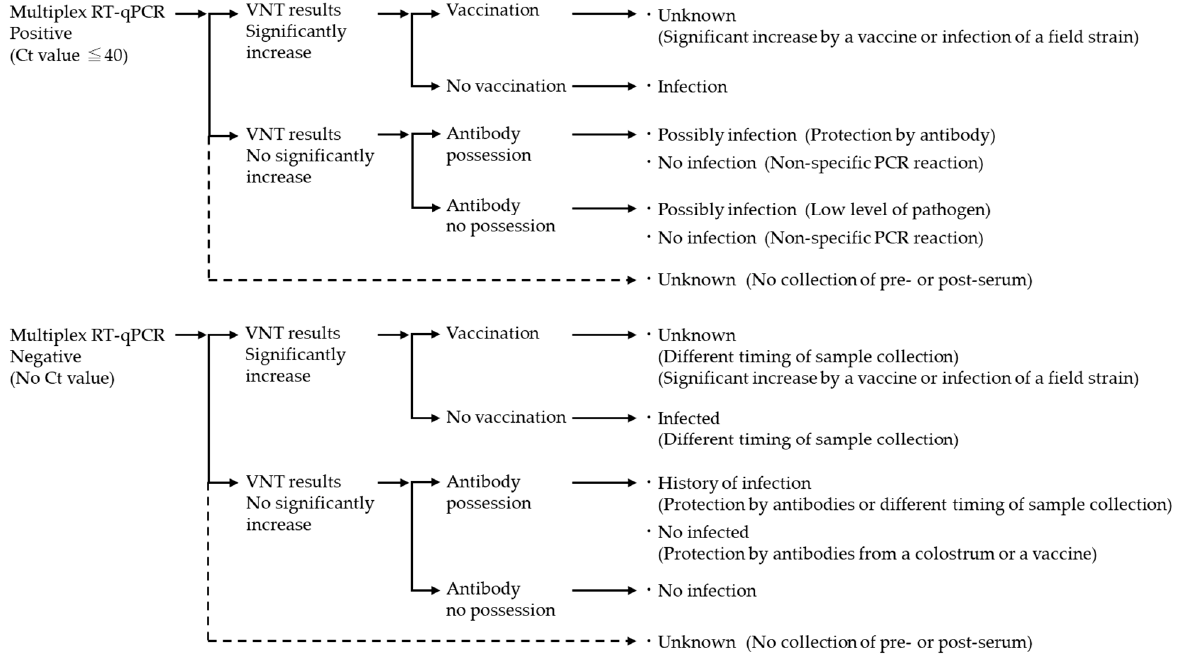
Figure 1. A flow chart to evaluate infection status based on results by multiplex RT-qPCR and results by VNT. “No collection of pre- or post-serum” means that the sample was not collected in a session before or after the session in which the result by multiplex RT-qPCR was positive.